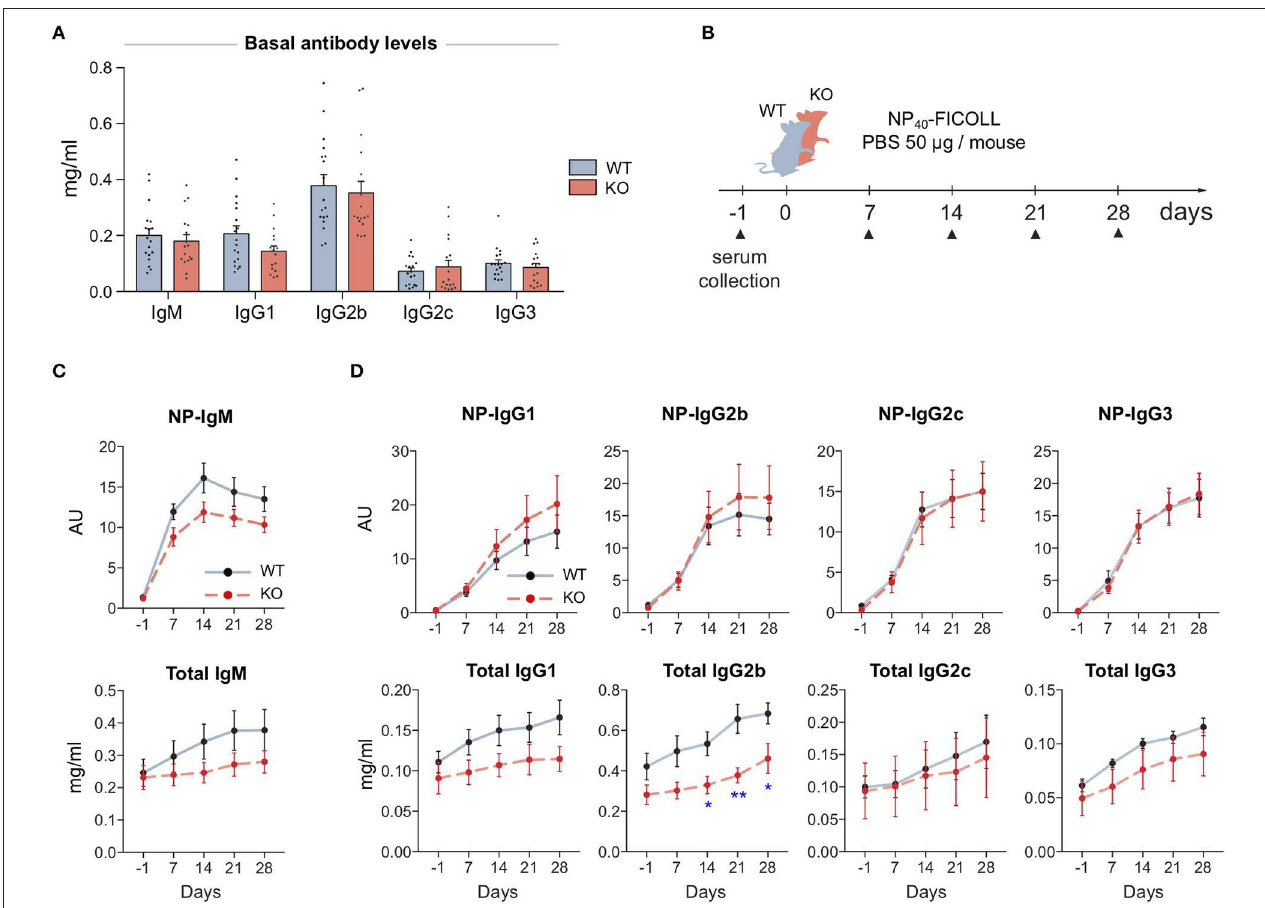
FIGURE 4 | MIM-deficiency results in impaired IgM response and reduced levels of total IgGs during T cell-independent immune response. (A) Basal antibody levels of major immunoglobulin subclasses were measured from 17 to 18 WT and MIM KO mice. (B) A schematic representation of T cell-independent (TI) immunization study. (C,D) The antibody responses of immunized WT and MIM-KO mice were followed from serum samples as in (B) . NP-specific and total antibody levels of (C) IgM and (D) IgG immunoglobulin isotypes were measured with ELISA. Seven to eight mice per group. Mean ± SEM is shown. * p < 0.05, ** p <